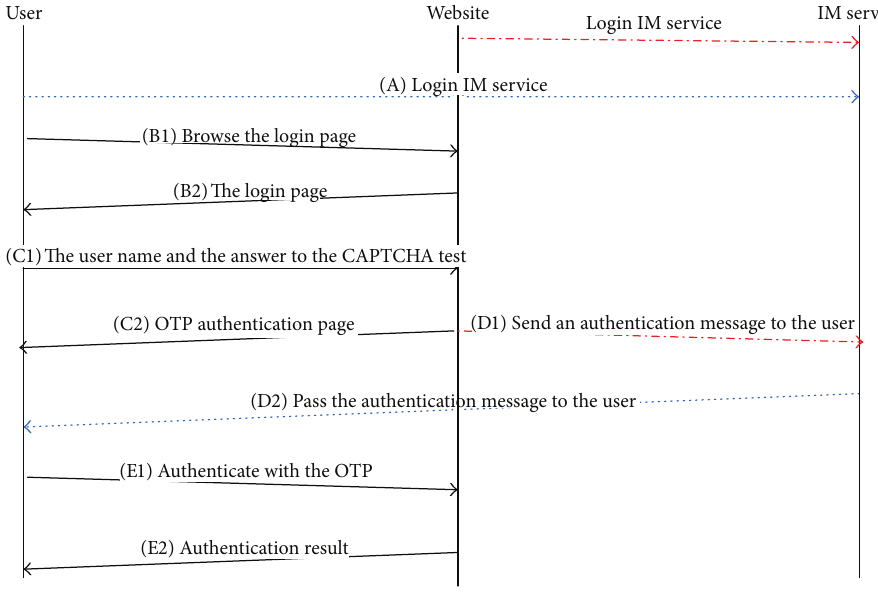
Figure 1: A login process through OTP